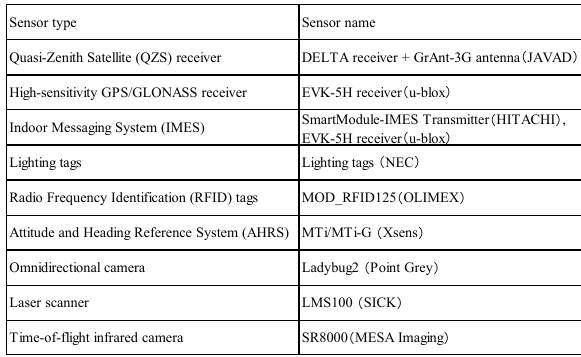
Table 1. Sensors used in the test